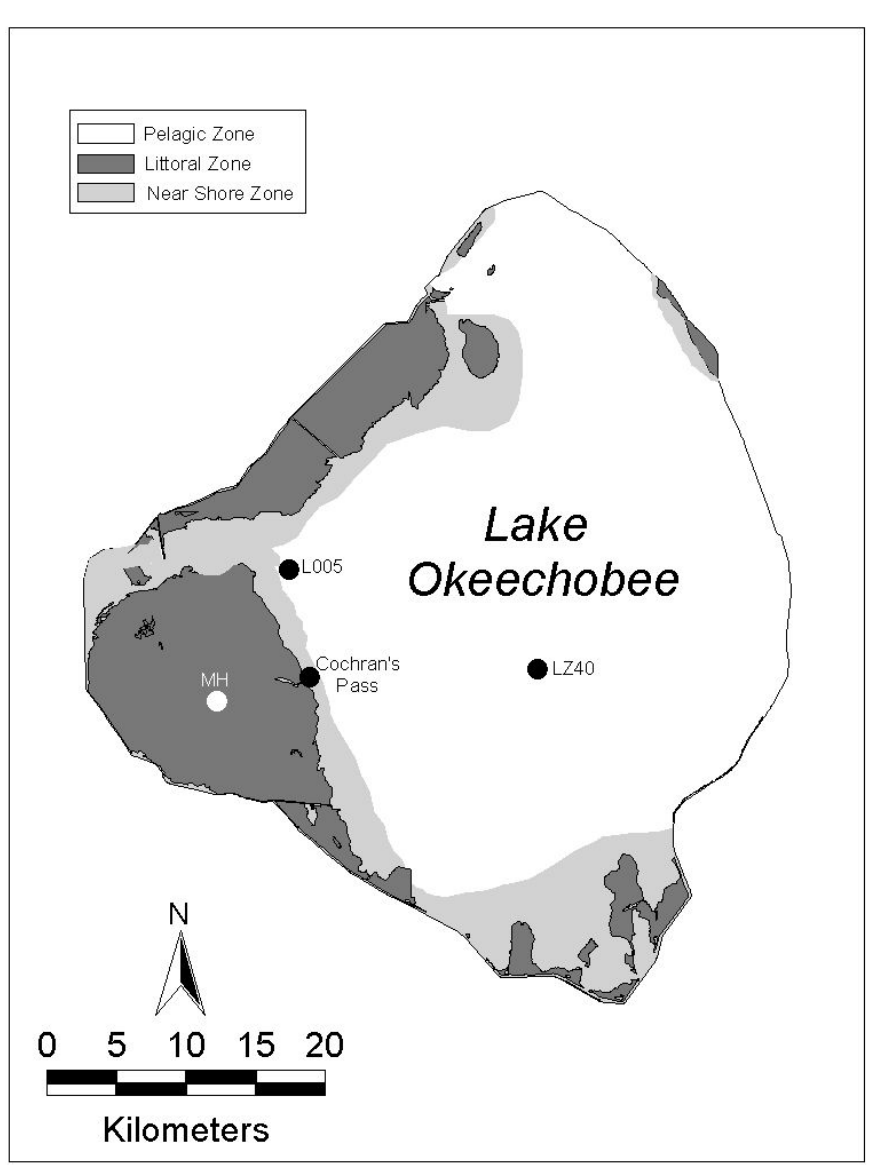
FIGURE 1. Map of Lake Okeechobee showing the locations of four sampling sites for stable isotope food web analysis. Three distinct lake regions, described in the text, also are indicated. White = pelagic (no plants), light gray = near-shore (dominated by submerged plants), dark gray = littoral wetland (dominated by emergent plants). Station names are MH = Moore Haven, CP = Cochran’s Pass, L005 and